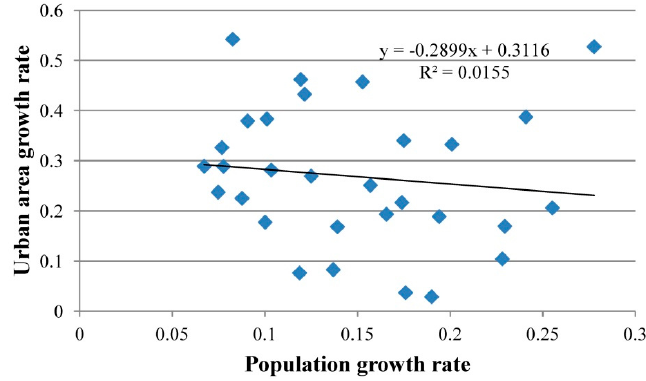
Figure 9. Normalized growth rates for urban population and nighttime lights between 1990 and 2010 for metropolitan areas in the Southeast U.S.A.